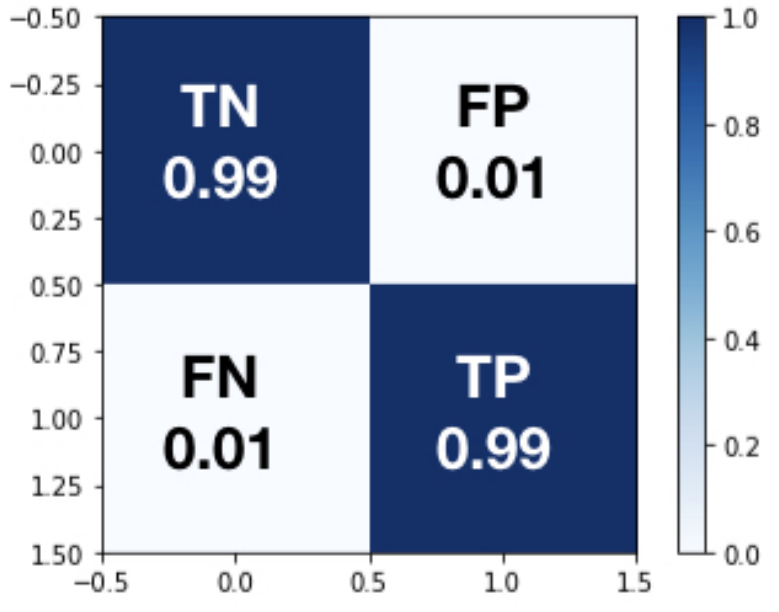
Figure 11. DL Model Testing Confusion